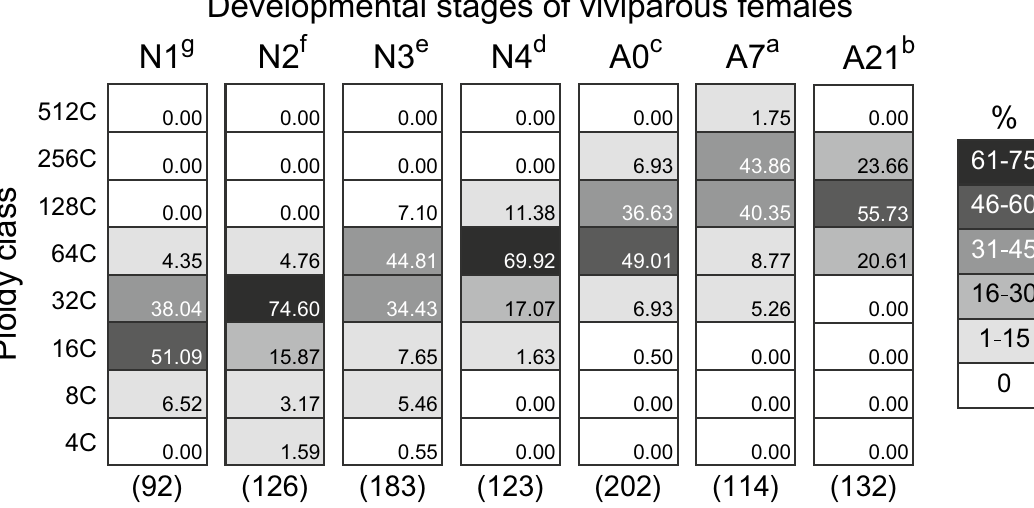
Figure 5. Ploidy distribution of bacteriocytes of each developmental stage of viviparous aphids. Sample size (numbers of bacteriocyte nuclei) is shown below each column. N1-4 represents the first to fourth instar nymphs, and A0, A7 and A21 indicate 0-, 7-, 21-day-old adults. Different letters with aphid stages indicate significant differences in the median ploidy class (Brunner–Munzel test with Bonferroni adjustment, p < 0.05). Bacteriocytes of adult viviparous females (A0-A21) in the pea-aphid were highly polyploid (64-256C), while those of N1 nymphs were mainly 16C and 32C